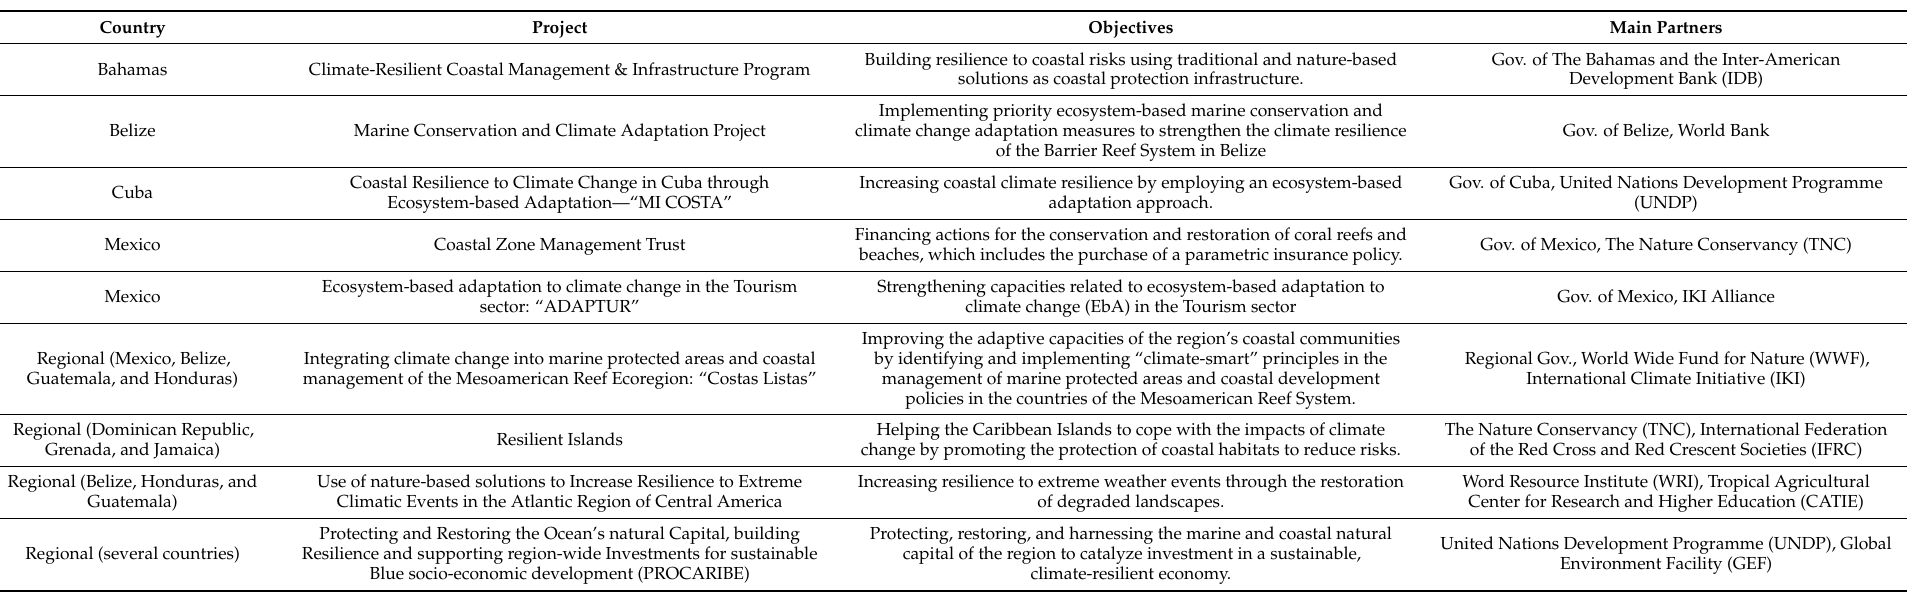
Table 1. Examples of NbS projects in Mexico, Central America, and the Caribbean. Source: Authors